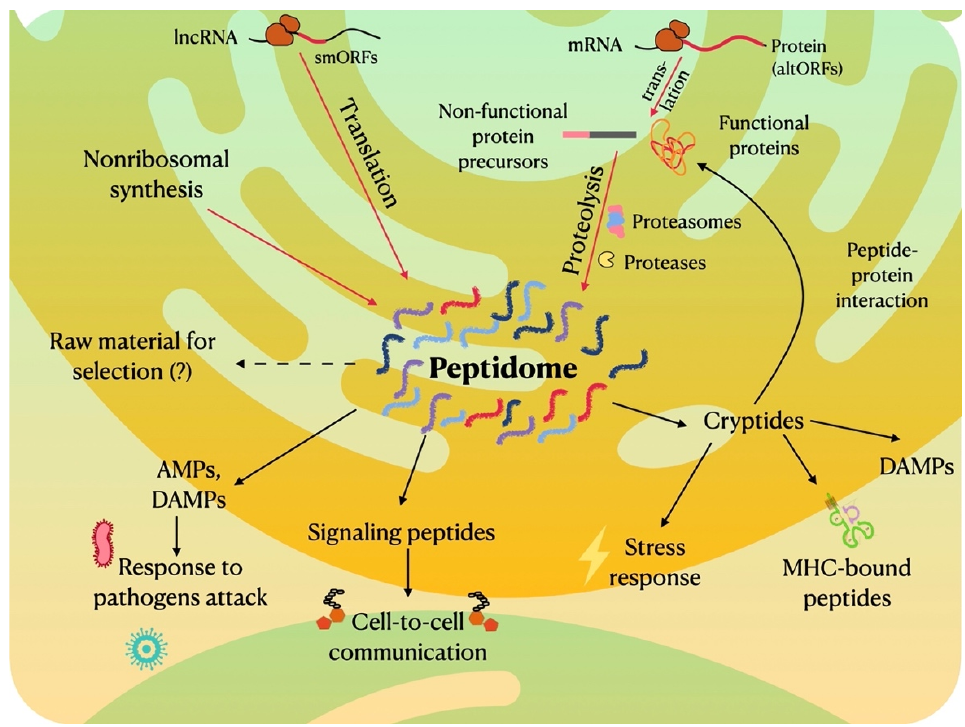
Figure 1. General scheme of generating and functioning pathways of naturally occurring peptidomes.